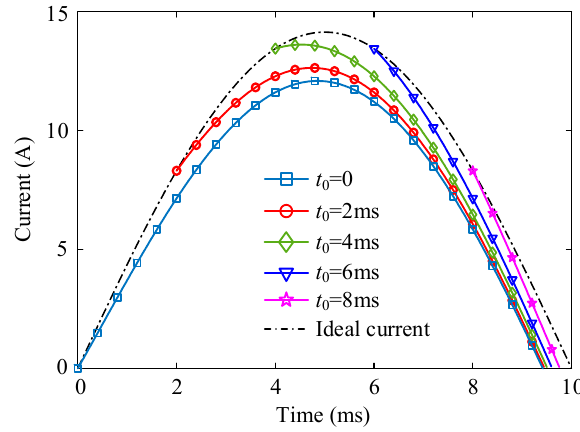
Figure 4. Arc current waveform under different ASTs.